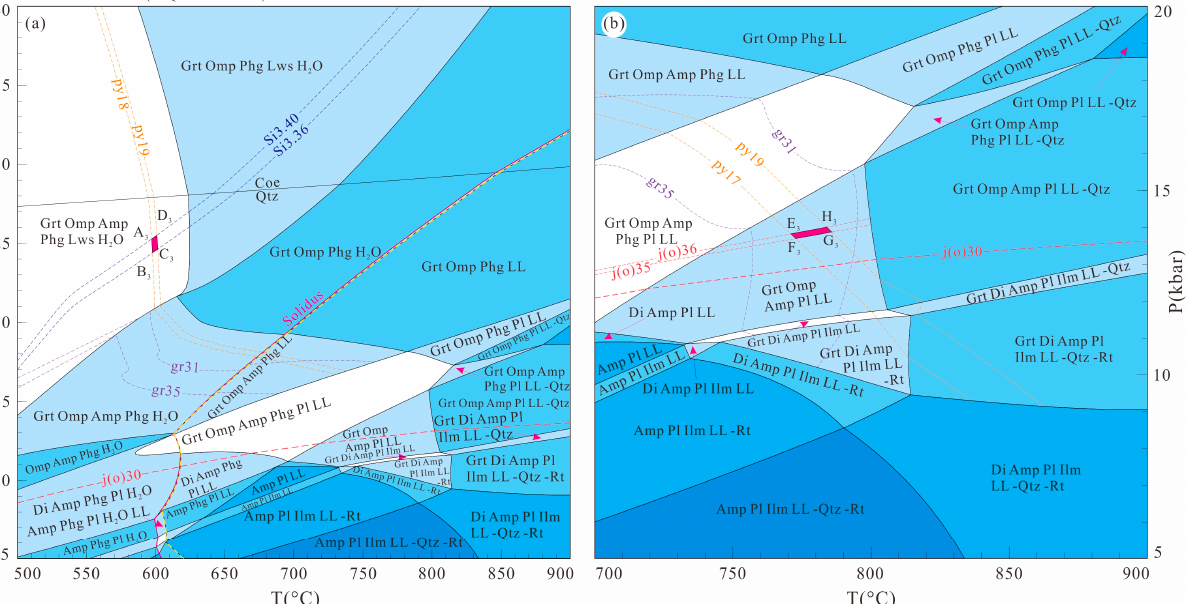
Figure 9. ( a ) P-T pseudosection for sample Y-32 calculated with the bulk-rock composition. ( b ) P-T pseudosection for sample Y-32 calculated with an effective bulk composition generated according to mass balance constraints from garnet rim and other relevant minerals. The compositions used for modelling are listed in Table 1. The pseudosection is contoured with isopleths of j(o) (i.e., j(o)35 is j(o) = 0.35 in Omp). Other details are the same as in Figure 7.